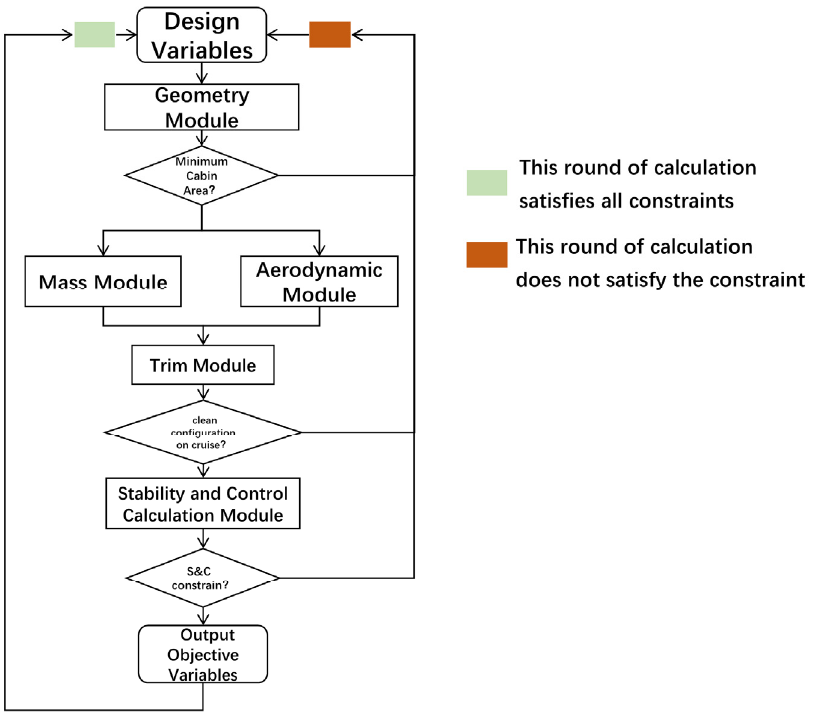
Figure 1. Program structure of the MDO design platform.